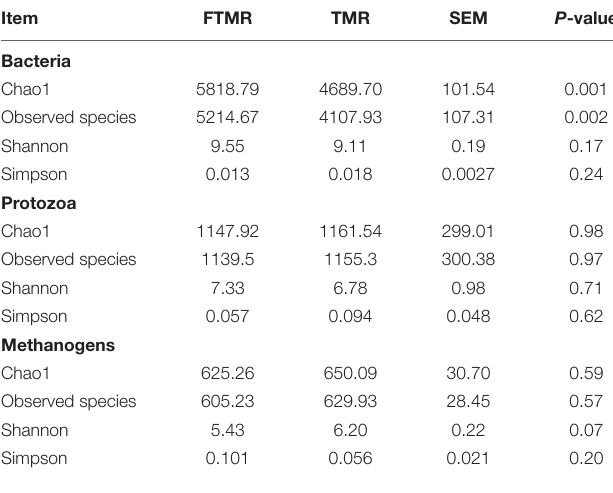
TABLE 6 | Changes in richness and diversity of rumen microbiome in fermenters fed fermented or non-fermented